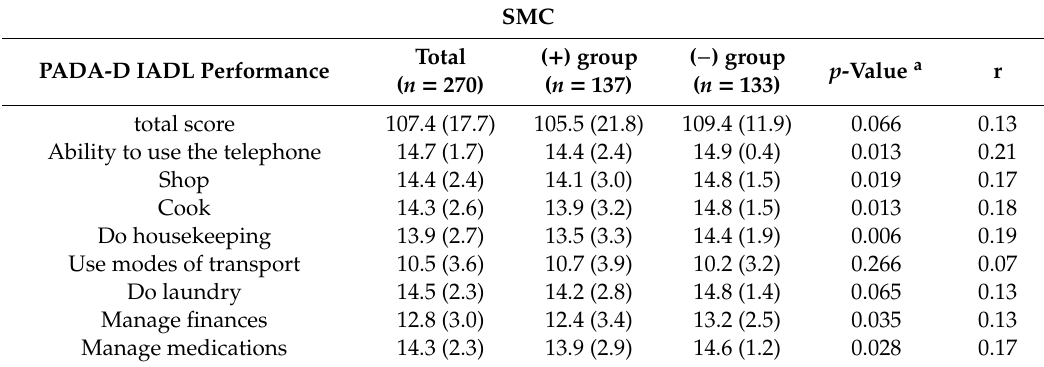
Table 4. Comparison on independence of IADL performance between with and without